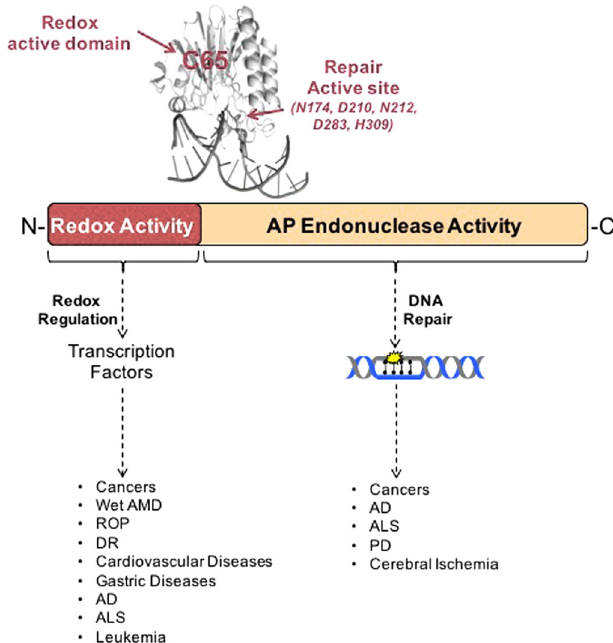
Fig. 4 Ref-1/APE1 in human diseases. Due to its multi-functional nature, Ref-1/APE1 impacts a wide range of human diseases. Altered expression of Ref-1/APE1 affects its regulation of multiple transcrip- tional factors, leading to various cancers, retinal, cardiovascular, gastric and neurodegenerative diseases. Similarly, modi fi ed Ref-1/ APE1 DNA repair function affects progression of different cancers and neurodegenerative diseases.